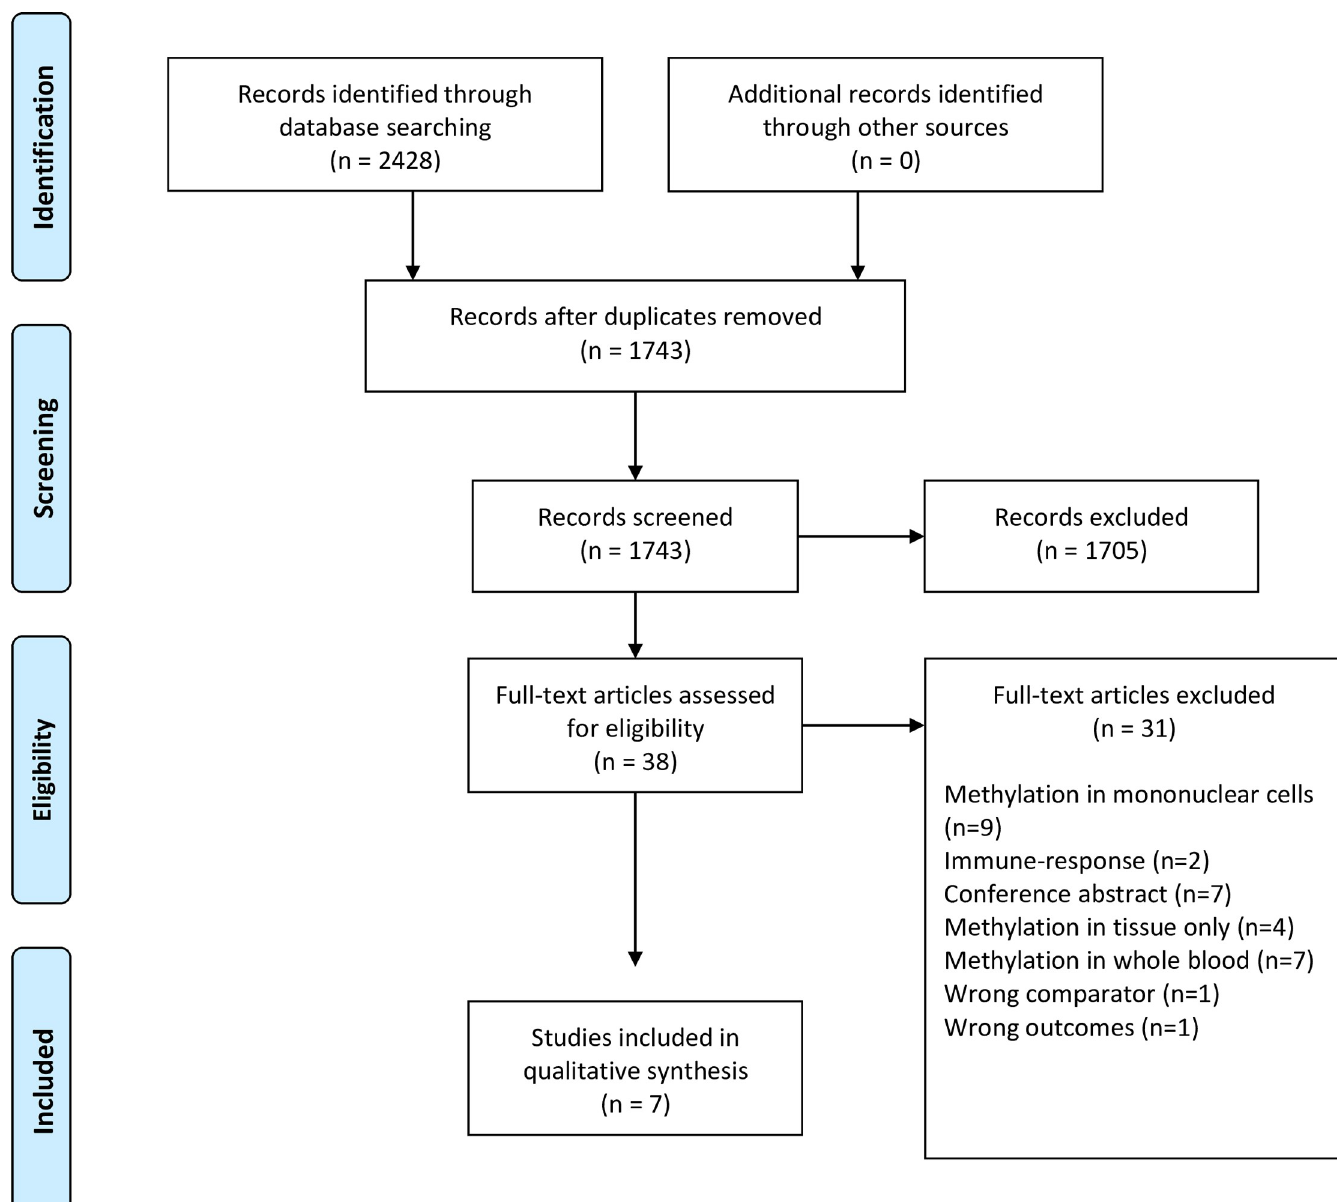
Fig 1. PRISMA flow diagram. From Moher et al.